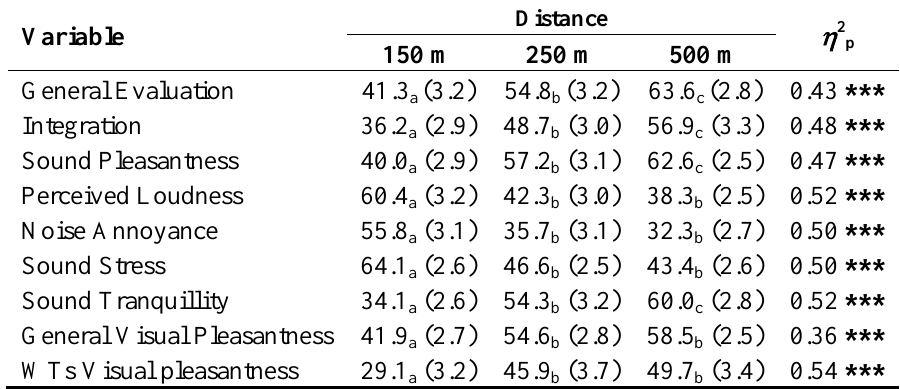
Table 4. Mean values (standard error) and effect size as a function of the Distance